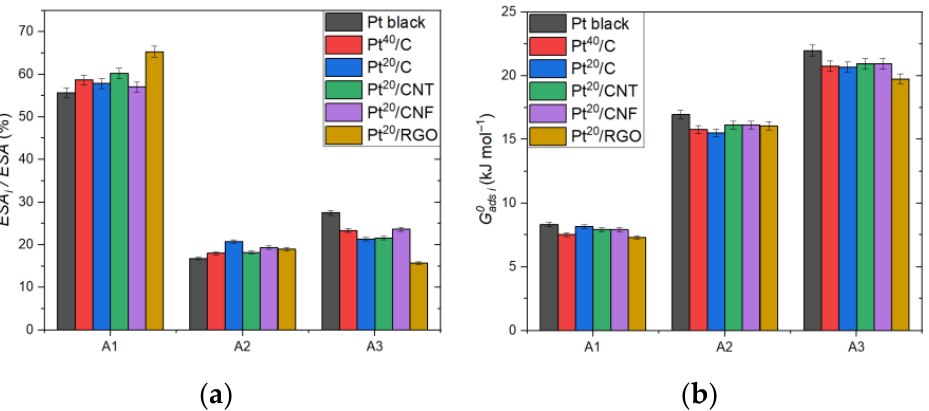
Figure 5. Normalized ESA ( a ) and adsorption energy ( b ) corresponding to the adsorption peaks A1, A2, and